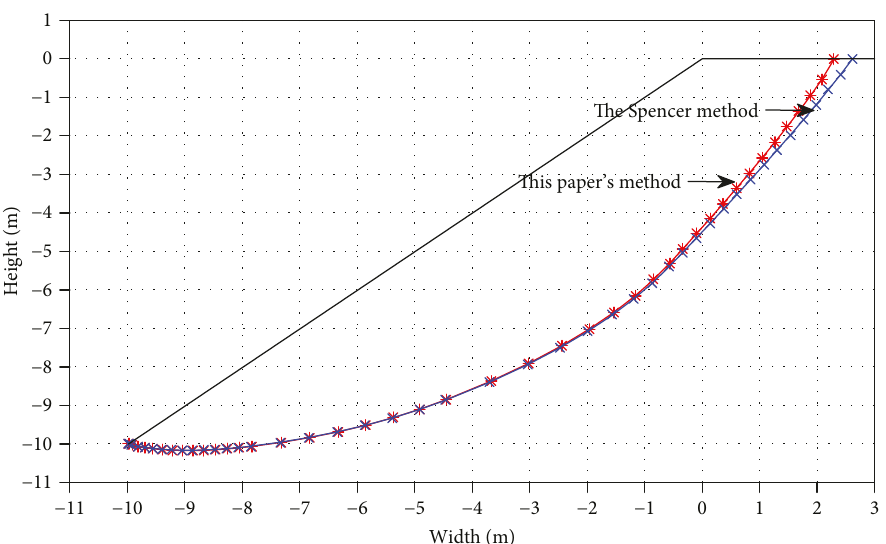
Figure 13: Comparison between this paper ’ s method and the Spencer